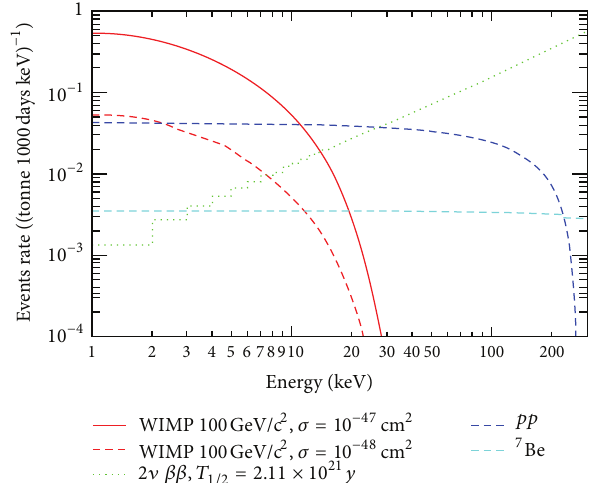
Figure 21: Expected nuclear recoil spectrum from WIMP scatters in LXe for a spin-independent WIMP-nucleon cross-section of 10 −47 cm 2 (red solid) and 10 −48 cm 2 (red dashed) and a WIMP mass of 100 GeV/c 2 , along with the differential energy spectrum for pp (blue) and 7 Be (cyan) neutrinos, and the electron recoil spectrum from the double beta decay of 136 Xe (green). Assumptions are 99.5% discrimination of electronic recoils, 50% acceptance of nuclear recoils, and 80% flat analysis cuts acceptance. Taken from